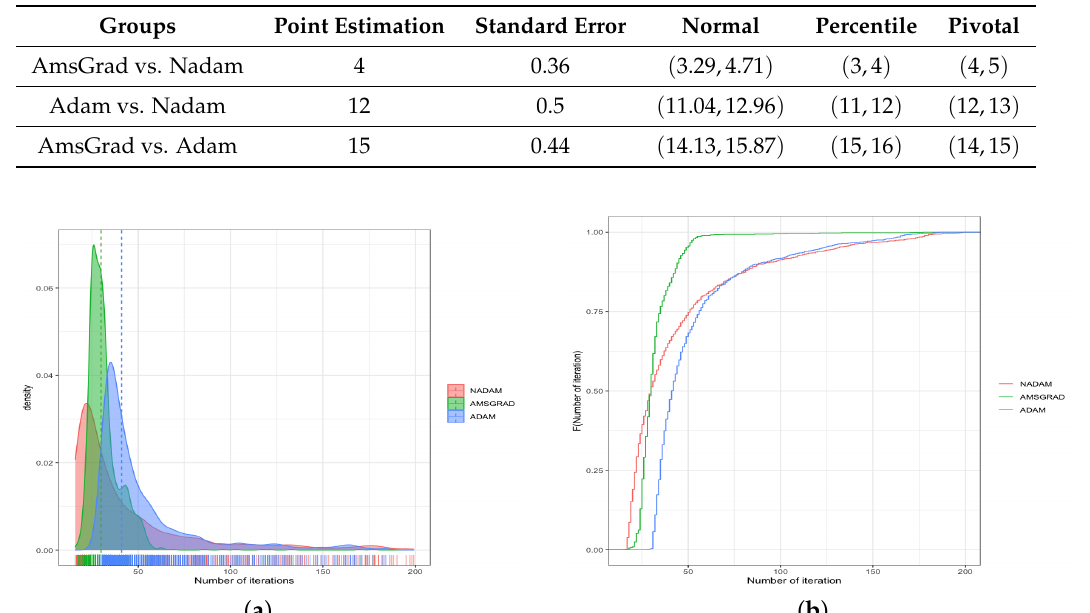
Table 5. The 95% non-parametric confidence intervals based on the bootstrap method.